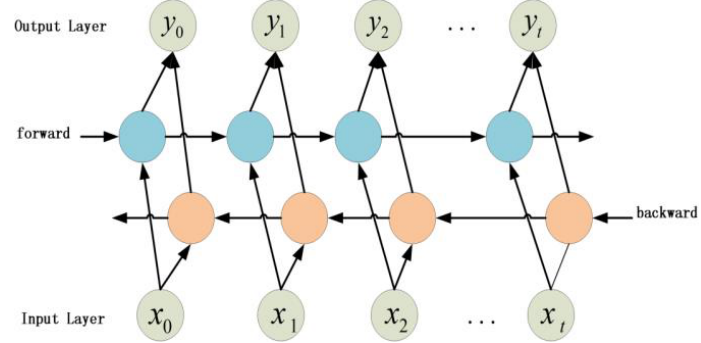
Figure 2. Computation flow of Bi-directional Regression Neural Network (BRNN) model.